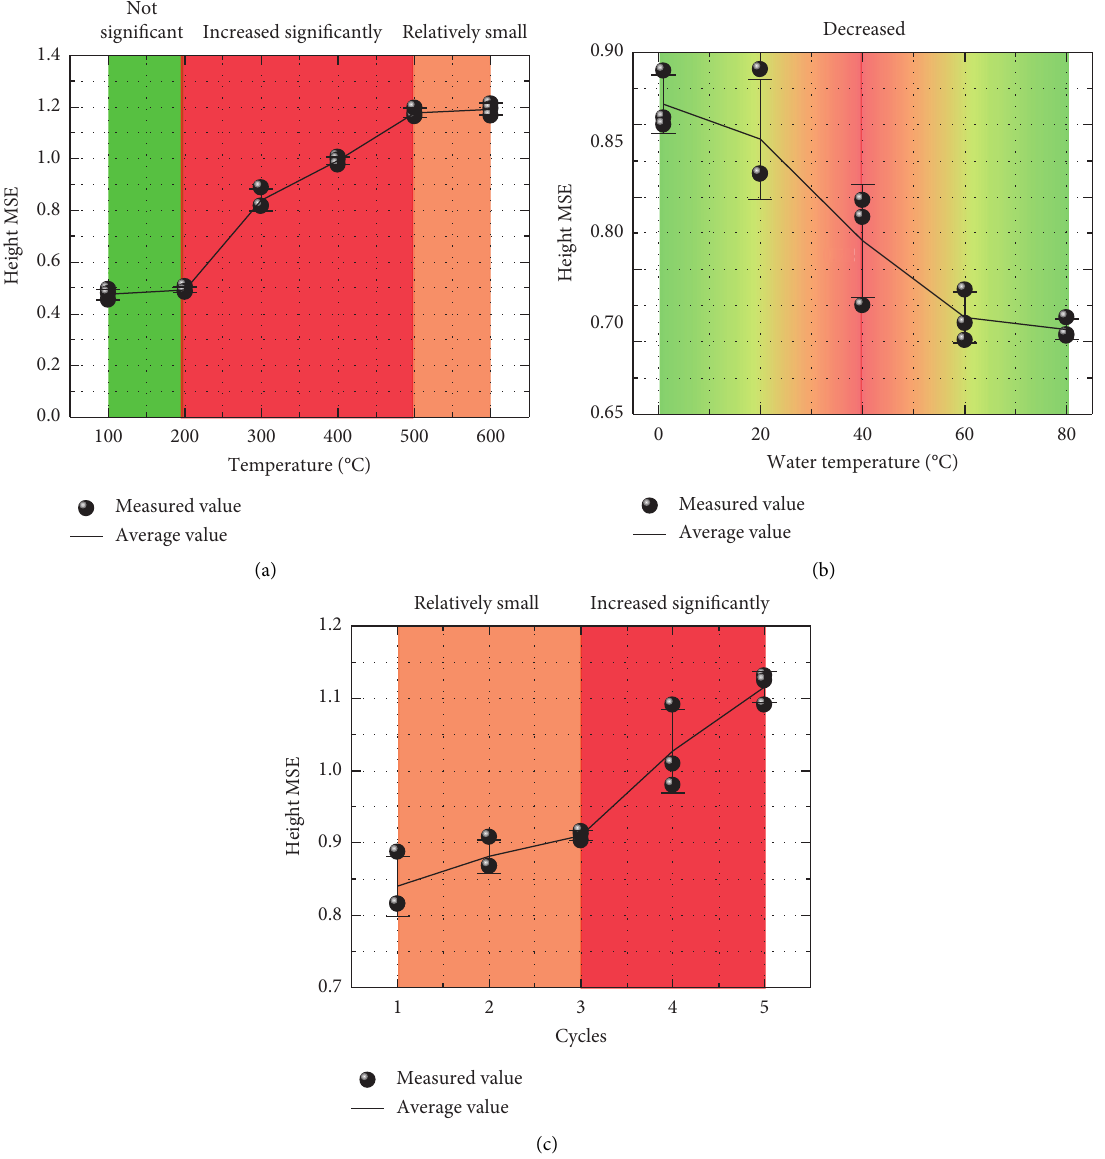
Figure 7: Height MSE of the specimen split surface under different conditions of water cooling at high temperatures. (a) HDR temperature. (b) Water temperature. (c) The number of heating-cooling